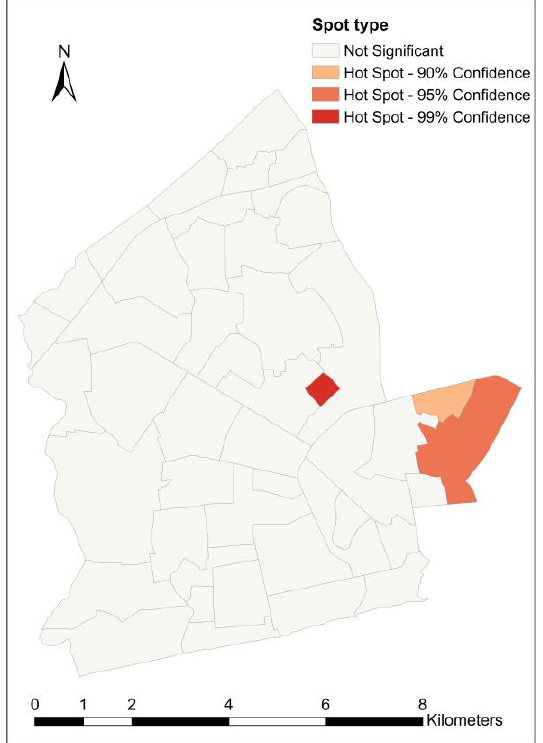
Figure 12. Hot spot neighborhoods for ratio of load shedding exposure to population.